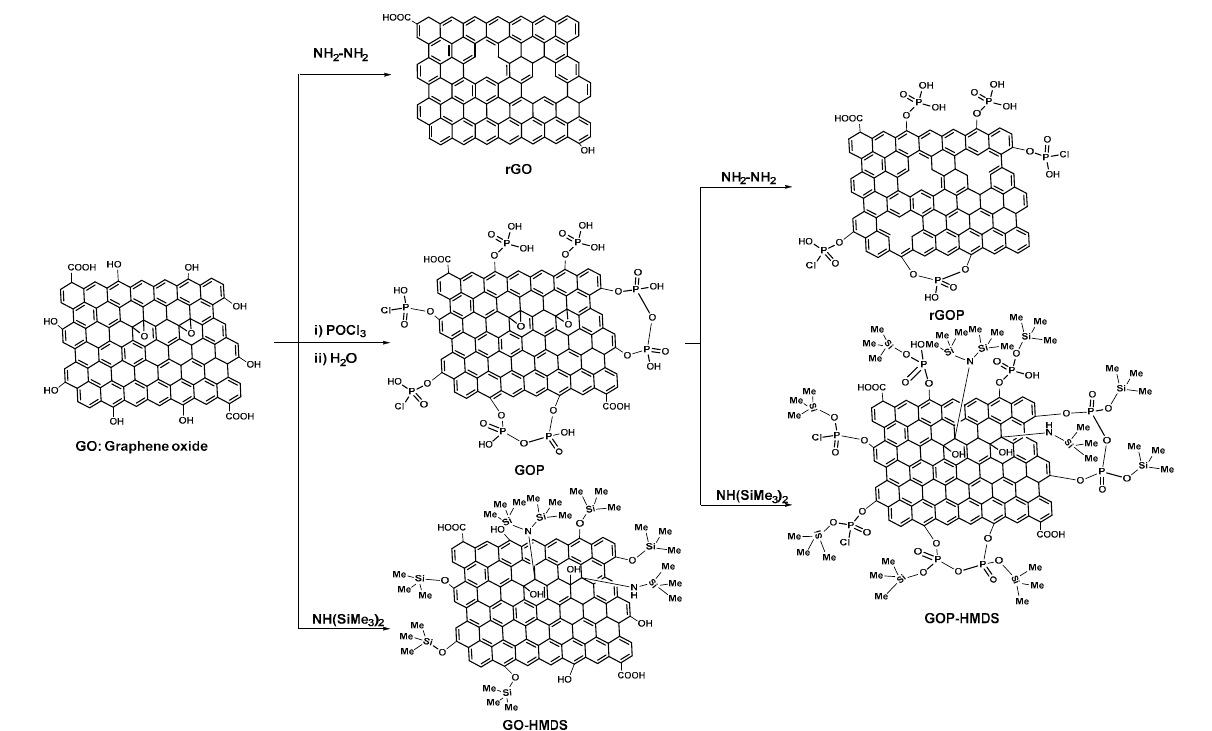
Figure 10. Scheme illustrating the synthesis of functionalized graphene fillers (GOP, rGOP, rGO, GO ‐ HMDS and GOP ‐ HMDS).